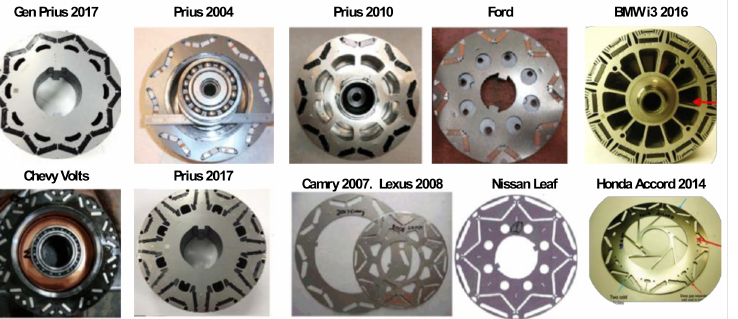
Figure 3. Rotors of electric machines for the recent hybrid electric vehicles (HEVs) and electric vehicles (EVs).